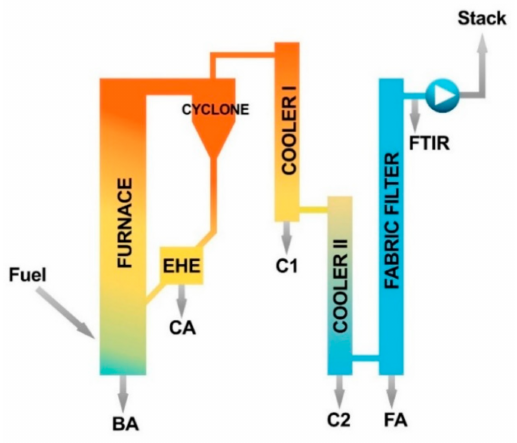
Figure 1. The 60 kW th circulating fluidized bed combustion test